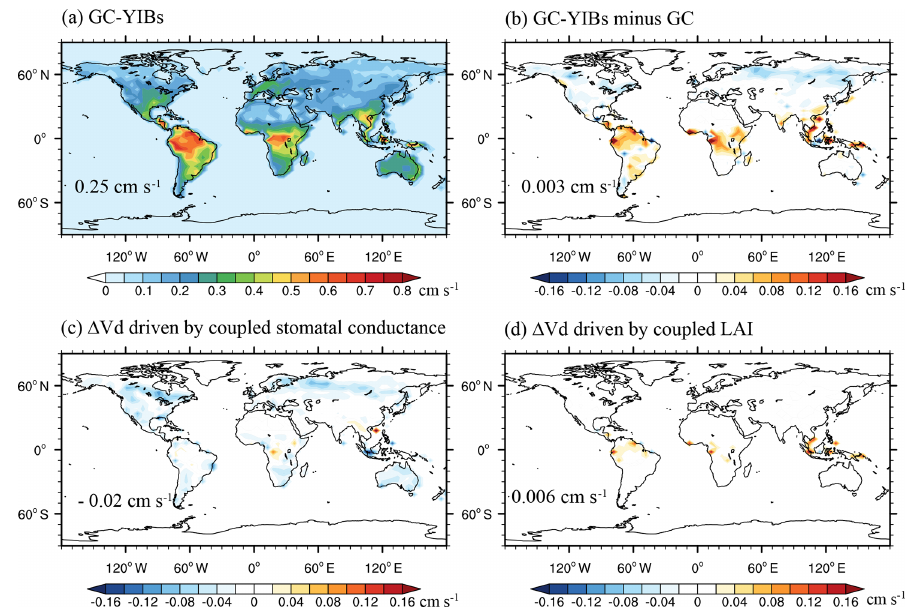
Figure 5. Simulated annual O 3 dry deposition velocity from online GC-YIBs model (a) and its changes caused by coupled LAI and stomatal conductance (b–d) averaged for the period of 2010–2012. The changes of dry deposition velocity are driven by (b) coupled LAI and stomatal conductance (Online_ALL – Offline), (c) coupled stomatal conductance alone (Online_ALL – Online_LAI), and (d) coupled LAI alone (Online_ALL – Online_GS). Global area-weighted annual O 3 dry deposition velocity and changes are shown in the panels.